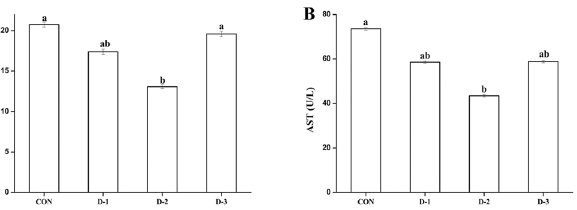
Fig 2. Effects of DMG-Na on ALT (A) and AST (B) activities in mice serum. Values are mean ± SEMs (n = 10). Mean of a variable without a common letter differ, P < 0.05. Alanine aminotransferase (ALT); Aspartate aminotransferase (AST). CON, gastric intubation in mice with 0 mg DMG-Na/0.3 ml sterile saline solution; D-1, gastric intubation in mice with 9 mg DMG-Na/0.3 ml sterile saline solution; D-2, gastric intubation in mice with 12 mg DMG-Na/0.3 ml sterile saline solution; D-3, gastric intubation in mice with 15 mg DMG-Na/0.3 ml sterile saline solution.